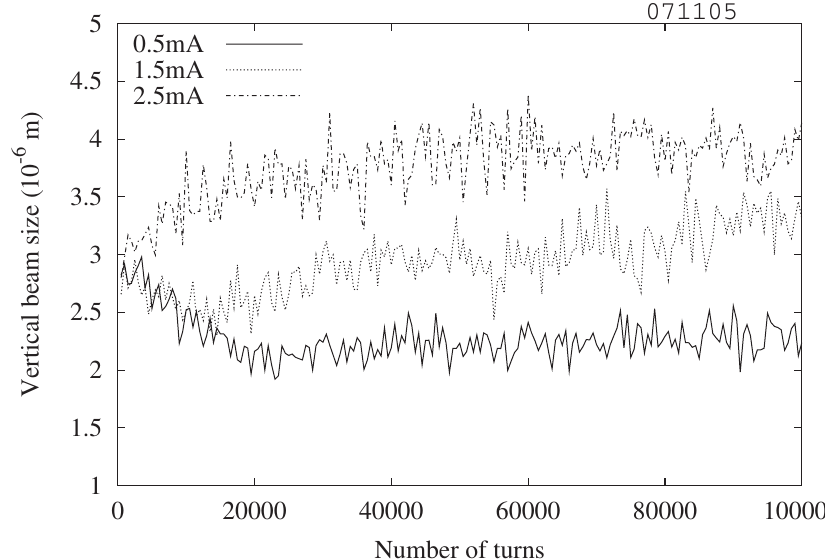
FIG. 1. Fitted vertical size of the weak beam distribution at the interaction point vs number of turns for several bunch